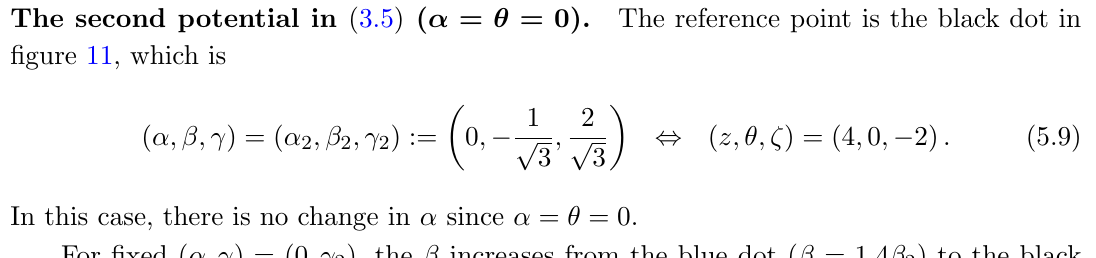
The reference point is the black dot